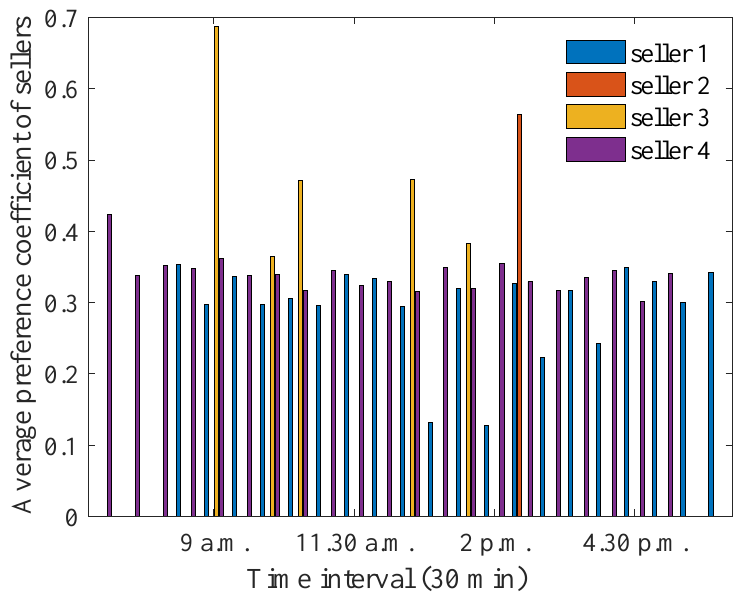
Figure 20. Optimum preference coefficients for sellers when distance between house 4 and the aggregator is